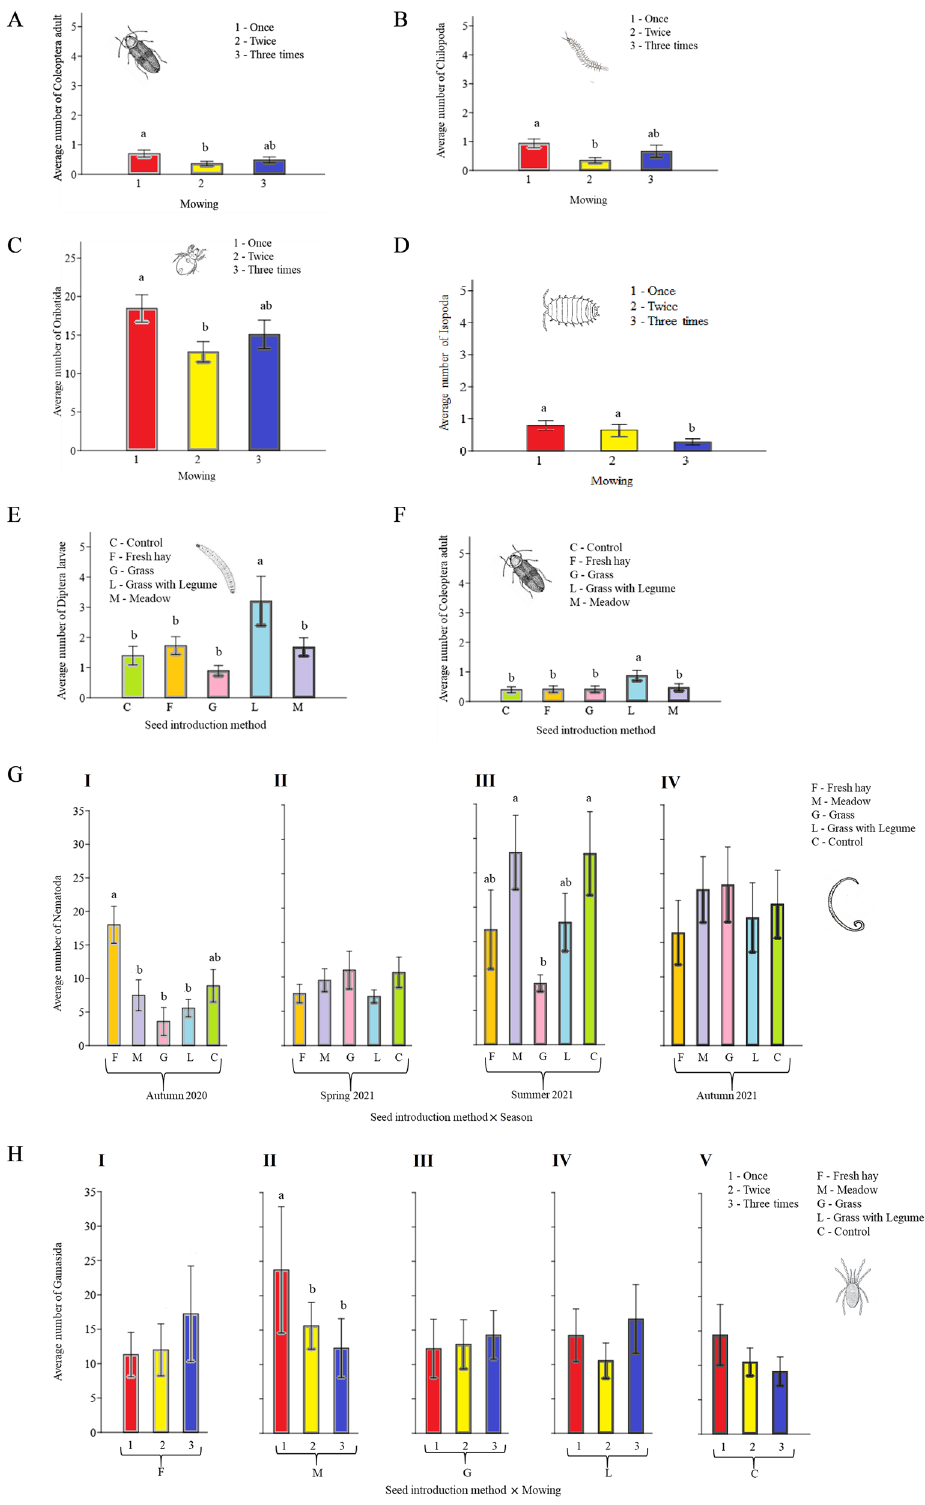
Figure 3. The effects of mowing and seed introduction methods, as well as their interactions, on the abundance of taxa. The different lowercase letters indicate significant differences between treatments; mowing regimes ( A – D ) and seed introduction method ( E , F ), p ≤ 0.05. The significance of differences is shown within the particular groups: ( G ) season and ( H ) seed introduction method, p ≤